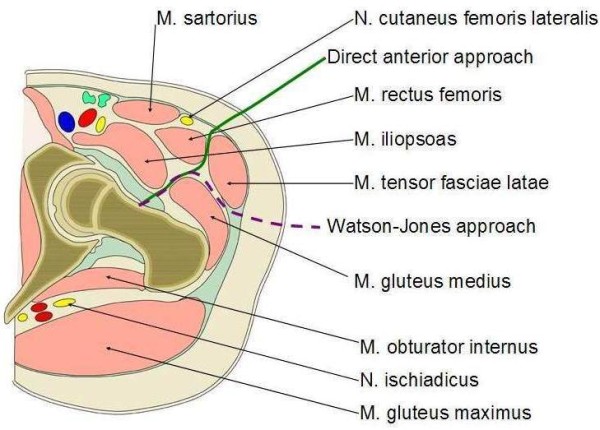
Surgical access anatomy. Comparison of access path with DAA (−−−) versus WJA (− − −).